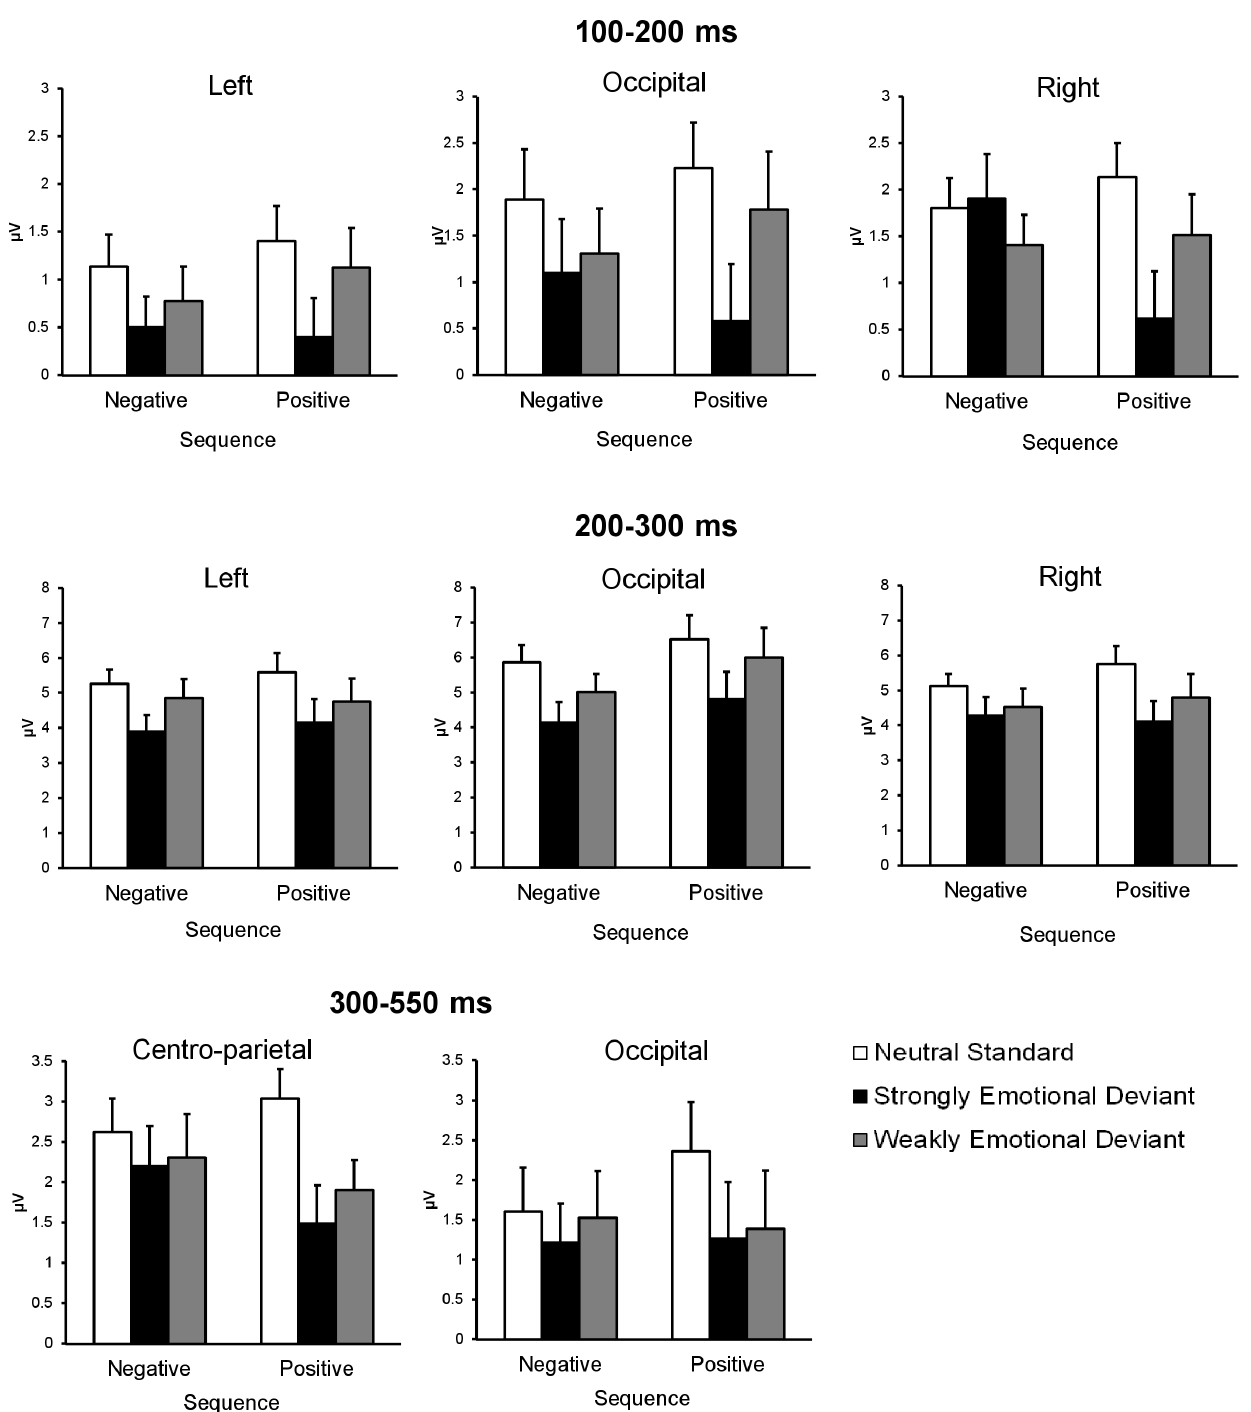
Figure 3. Mean amplitudes and SEMs of ERPs for each condition. ERP amplitudes for neutral standards, strongly emotional deviants, and weakly emotional deviants in negative and positive sequences. For all of the time windows, ERP amplitudes were averaged across three occipital electrodes (O1, O2, and Oz). In addition, for 100–200 ms and 200–300 ms, ERP amplitudes were averaged across two posterior electrodes over the right hemisphere (TP8 and P8), and two homologous electrodes over the left hemisphere (TP7 and P7). For 300–550 ms, ERP amplitudes were averaged across three centro-parietal electrodes (FCz, Cz, and CPz). doi:10.1371/journal.pone.0063703.g003 positive sequence (Kou: happiness) but incongruent with the standard in the negative sequence (Byo: sickness) but not in the standard in the negative sequence (Byo: sickness). Conversely, the positive sequence (Kou: happiness). Both sequences included task- negative deviant (Gai: harm) was emotionally congruent with the relevant stimuli (i.e., targets). Whereas standards and deviants